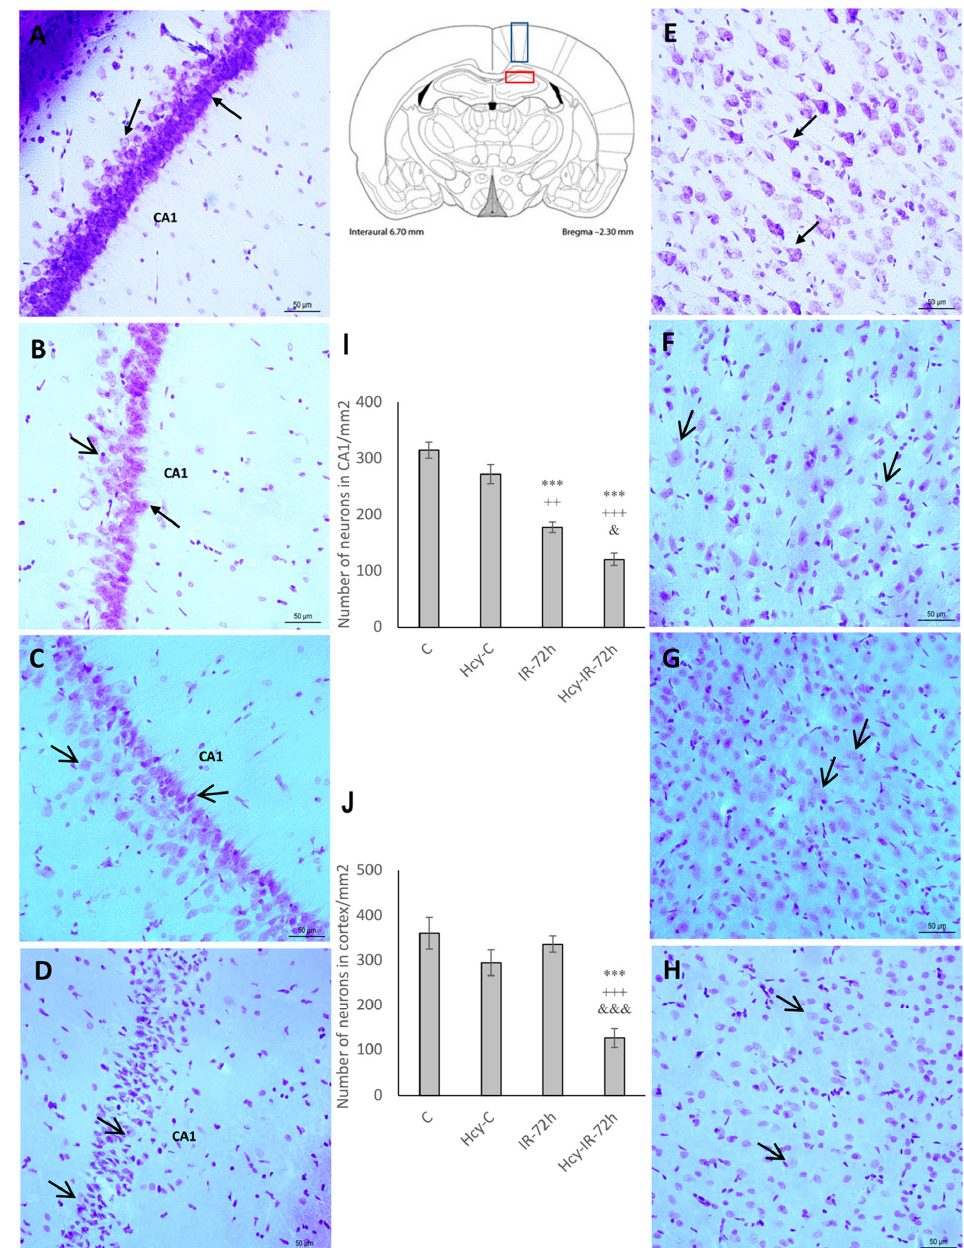
Figure 1. Cresyl violet stained rat brain sections and statistical evaluation of changes in number of vital neurons in the CA1 (cornu ammonis 1) region of hippocampus and M1 (primary motor cortex) region of rat brain cortex. Bright-field micrographs of CA1 region of hippocampus representing naive control ( A ), homocysteine-treated control (Hcy-C) ( B ), naive ischemia followed by 72 h of reperfusion (IR-72h) ( C ), Hcy-IR-72h ( D ) and micrographs of M1 region of rat brain cortex representing naive control ( E ), Hcy-C ( F ), naive IR-72h ( G ) and Hcy-IR-72h ( H ). Arrows indicate morphologically changed neurons, while arrow heads show vital neurons. Bar = 50 µm, n = 5/group. Schematic coronal rat brain section (according to Paxinos and Watson [34]) showing CA1 area of rat hippocampus (red rectangle) and M1 region (blue rectangle) of cerebral cortex. Number of vital neuronal cells in the CA1 area of hippocampus ( I ) and M1 region of rat brain cortex ( J ) in naive control, Hcy-C, naive IR-72h and Hcy-IR-72h. Results are presented as mean ± SEM, n = 5/group. *** p < 0.001 versus the control value; ++ p < 0.01 and +++ p < 0.001 versus the control with Hcy; & p < 0.05 and &&& p < 0.001 versus the corresponding reperfusion